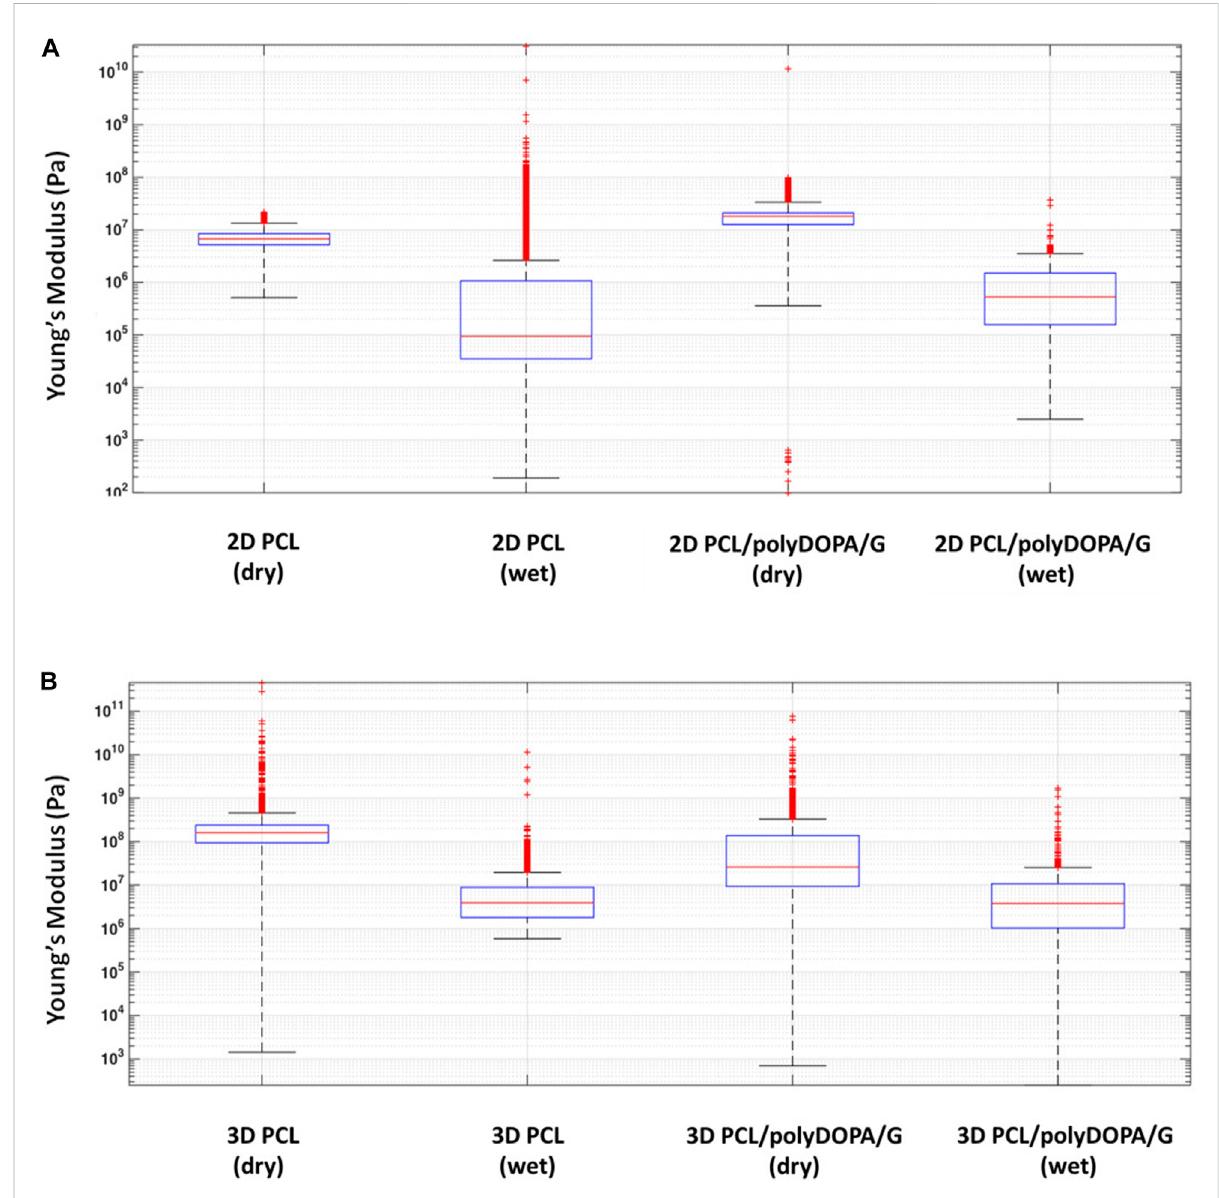
FIGURE 4 Boxplotgraphof (A) theextractedYoung ’ smodulusfromthecollectedextendedcurvesof2DPCLand2DPCL/polyDOPA/Gsamplesinairand water immersion conditions and (B) 3D PCL and 3D PCL/polyDOPA/G samples in the same